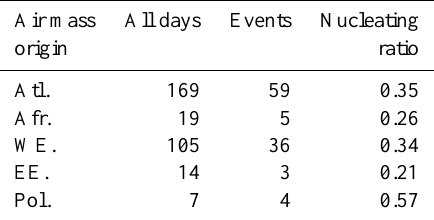
Table 1. Formation rates calculated from different parametrizations.